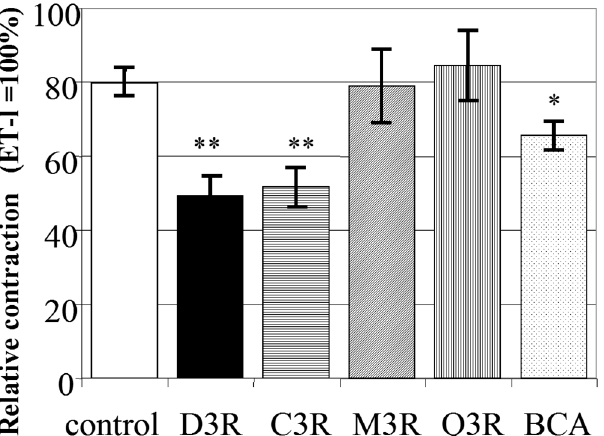
Figure 6. Summary of data obtained from relaxation during a 60 minute treatment of four flavonoids compared to the control. * p < 0.05, ** p < 0.01; significantly different compared to the control. The data represent the force generated with ET-1 (10 nM) set to 100%. n = 6, mean ± SEM.